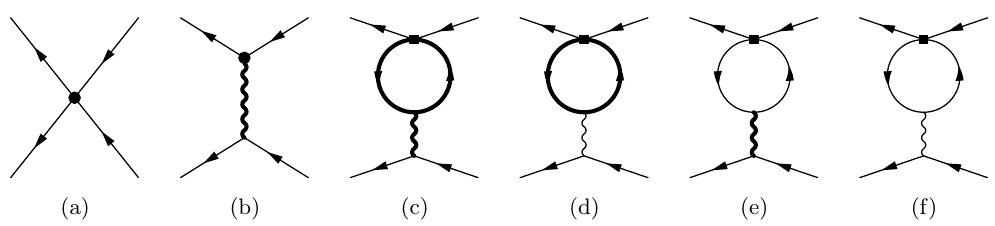
Figure 2 . Diagrams contributing to the Wilson coe(cid:14)cient of ((cid:22) e iL (cid:13) (cid:22) e jL ) ((cid:22) e kL (cid:13) (cid:22) e nL ) above the electroweak scale m EW , computed with Lagrangian L e(cid:11) . Thick (thin) lines denote heavy (light) (cid:12)elds. Diagram (2.a) comes from (cid:14) L L , (2.b) from (cid:14) L V . The diagrams (2.c){(2.f) come from the four-fermion interactions of L 0 ((cid:3)), eq. (2.3), denoted by a square. They cancel the dependence NP on the renormalization scale (cid:22) of the diagrams (2.a),